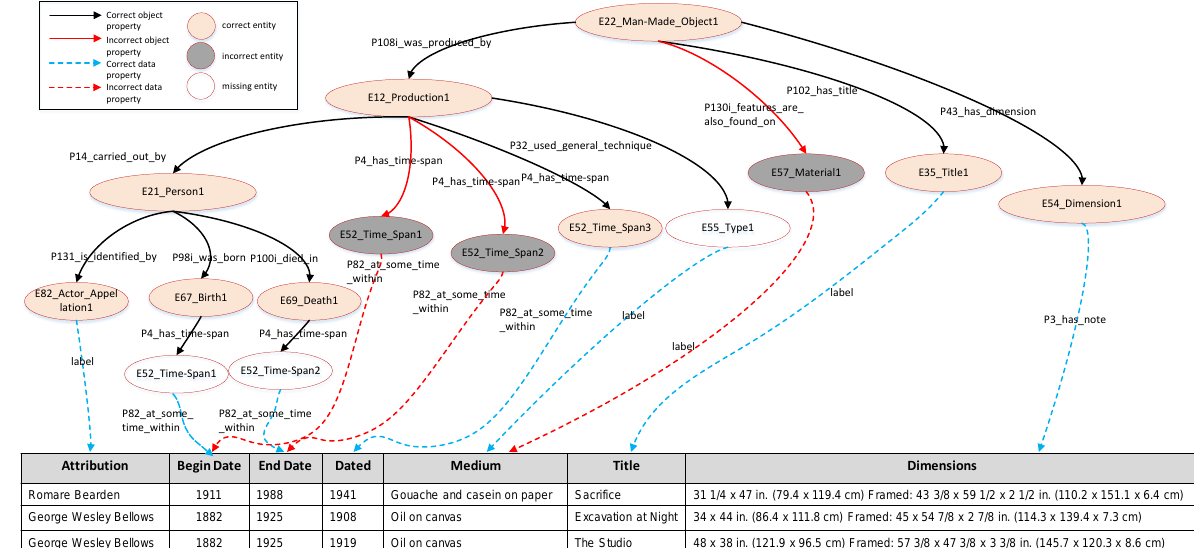
Figure 3. The seed model of CB. The incorrect entities are in the gray background, and incorrect relationships are colored red. The missing entities are on a white